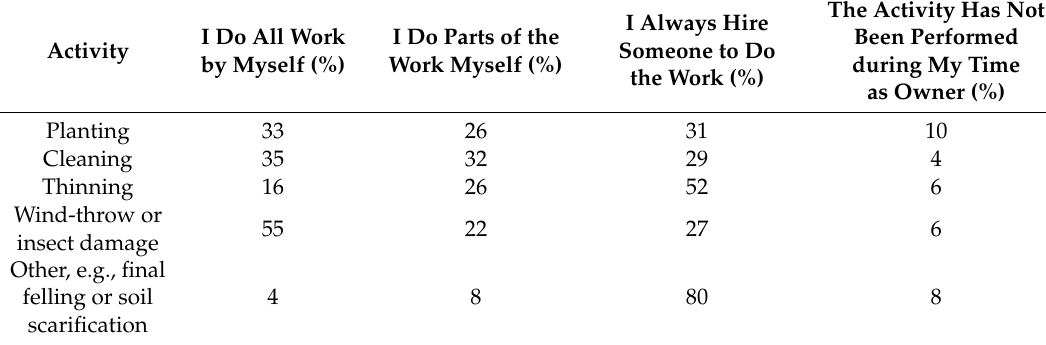
Table 7. Percentage of forest owners who take care of the management activities themselves or hire contractors for all or parts of the